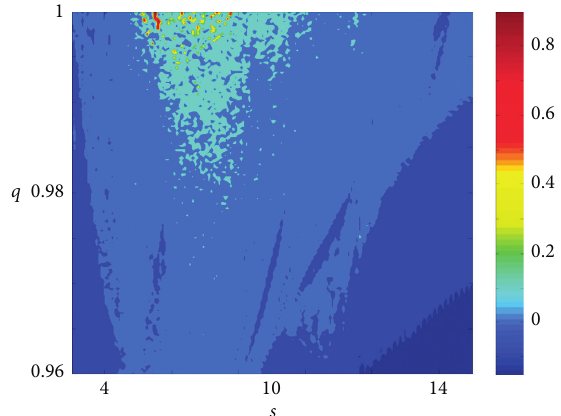
Figure 5: The chaos diagram of the maximum Lyapunov exponent contour plot in the s-q parameter plane.